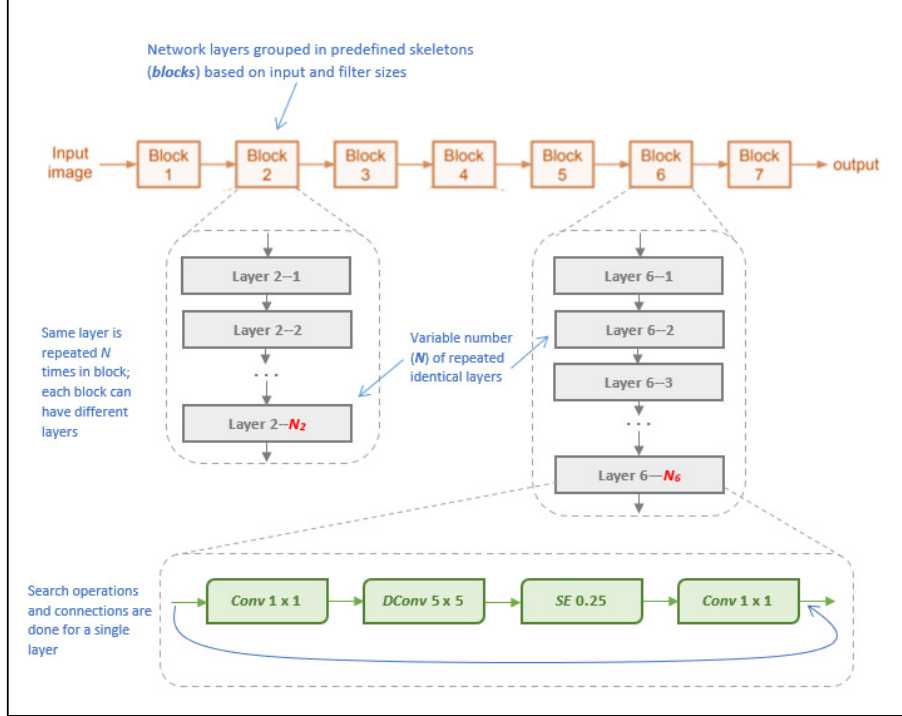
Figure 9. Visual overview of NasNetMobile architecture (as described in [26]).